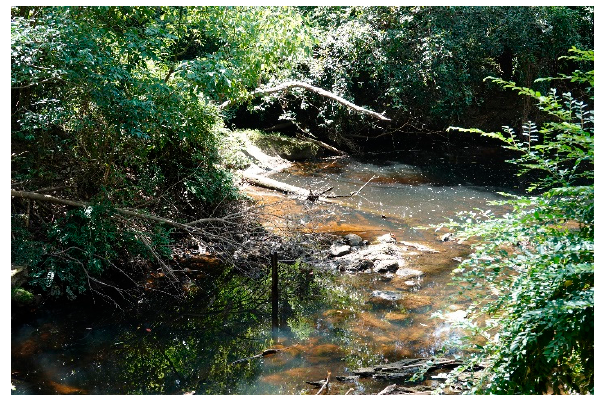
Figure 3. Image: Brown’s Waterhole—Image: J. Rey, 2018.